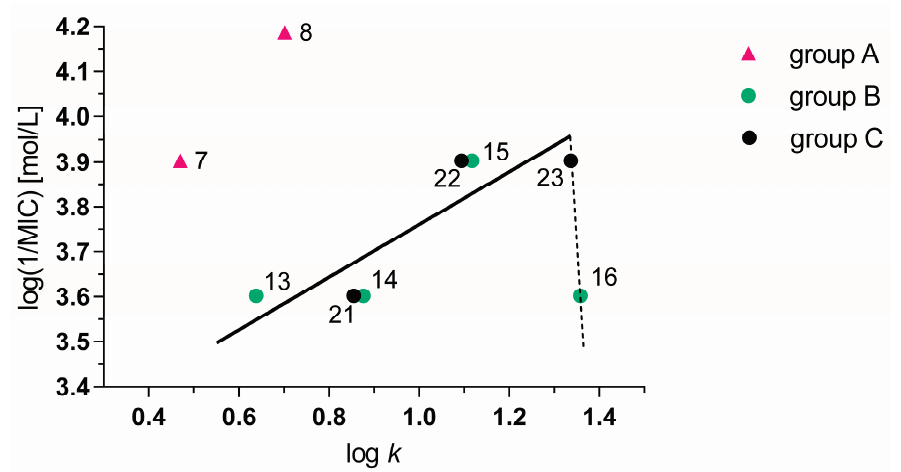
Figure 3. Dependence of antifungal activity of tested compounds against T. mentagrophytes on log k